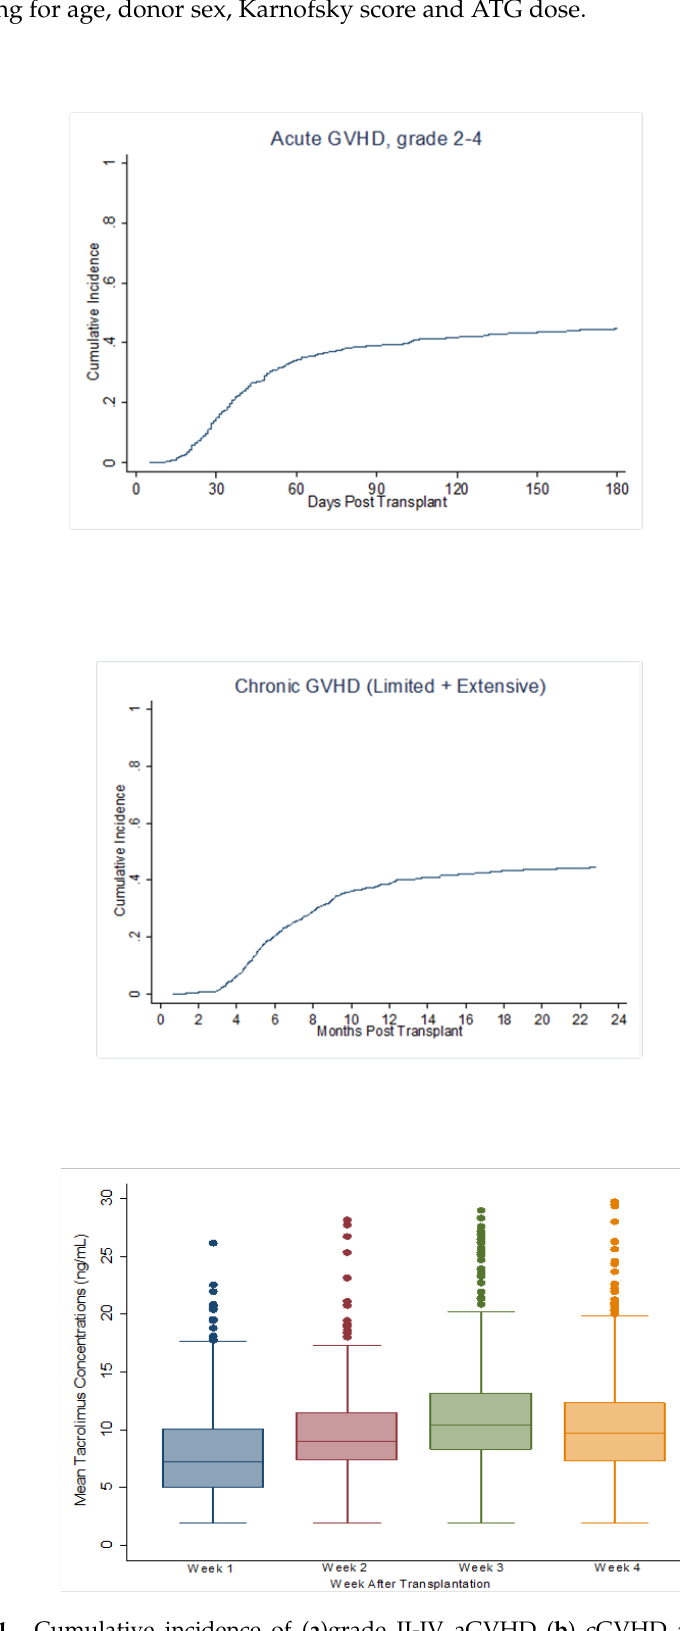
Figure 1. Cumulative incidence of ( a )grade II-IV aGVHD ( b ) cGVHD and ( c ) mean weekly tacrolimus levels.